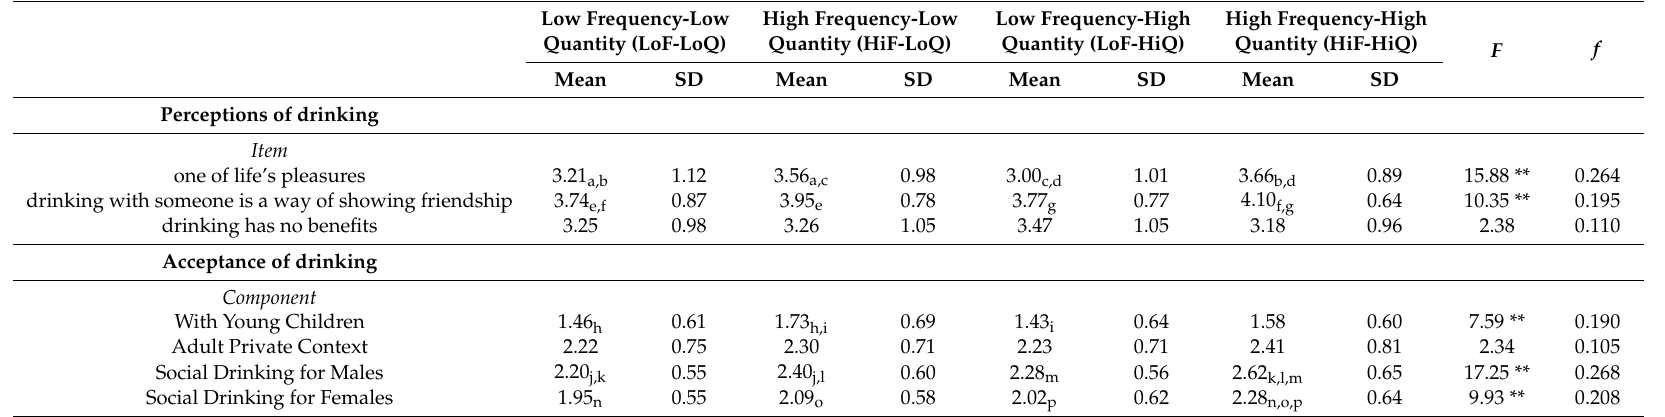
Table 5. Perception of drinking and acceptance of drinking by drinking